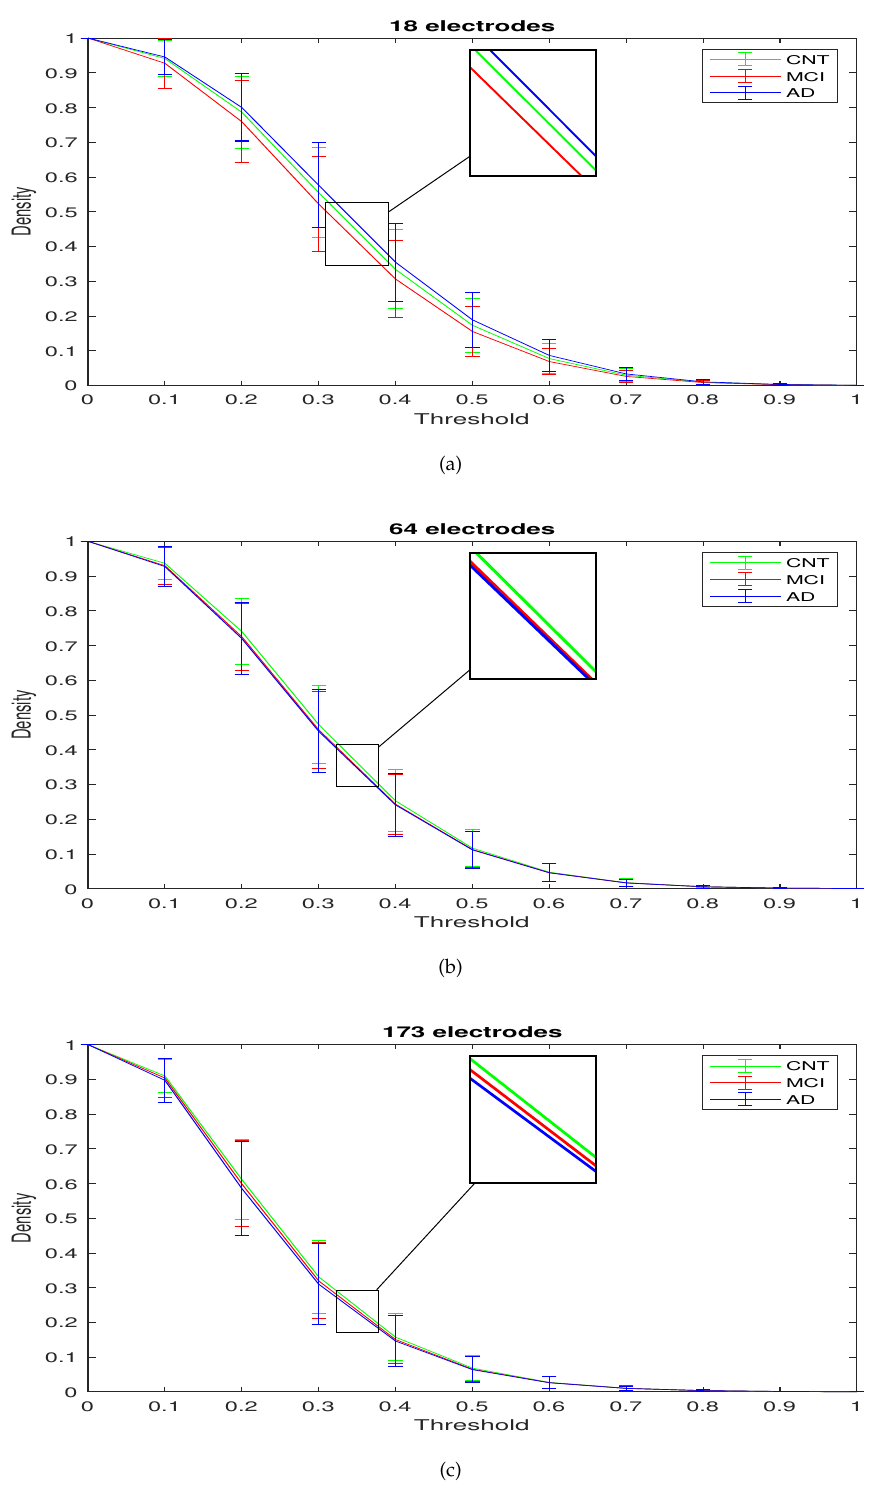
Figure 3. Mean values of the Connection Density (D) computed by thresholding the connectivity matrix of CNT, MCI, and AD for: ( a ) 18 electrodes, ( b ) 64 electrodes and ( c ) 173 electrodes. The vertical segments represent the standard deviation of D.